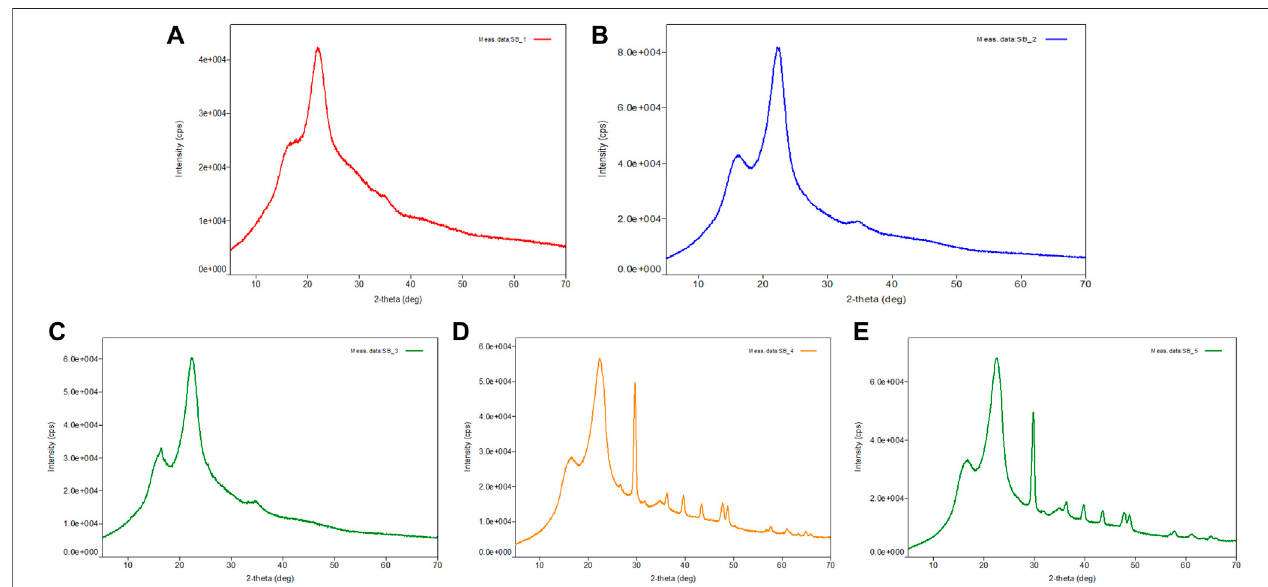
FIGURE 2 | X-ray diffraction (XRD) pattern of native, acid-, and alkali-pretreated sugarcane bagasse (SB). The crystallinity index (CrI) was found to be increased in cellulignin and NaOH-pretreated bagasse. Enzymatic hydrolyzed SB showed the CrI value of cellulignin and NaOH-treated bagasse. (A) Untreated sugarcane bagasse, (B) 5% sulfuric acid-pretreated bagasse at 121 ° C for 60 min, (C) 10% sulfuric acid-pretreated bagasse at 121 ° C for 60 min, (D) 5% sodium hydroxide-pretreated bagasse at 121 ° C for 60 min, and (E) 10% sodium hydroxide-pretreated bagasse at 121 ° C for 60 min. CrI, crystallinity index; SB, sugarcane bagasse; XRD, X-ray diffraction.